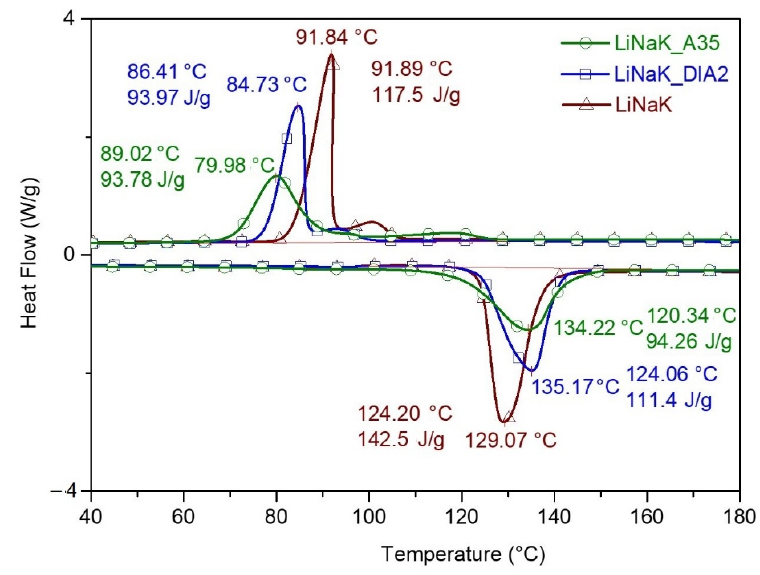
Figure 5. DSC curves of LiNaK salts and SSPCM based on DIA2 and A35 around the phase transition peaks at the 2nd heating/cooling cycle.